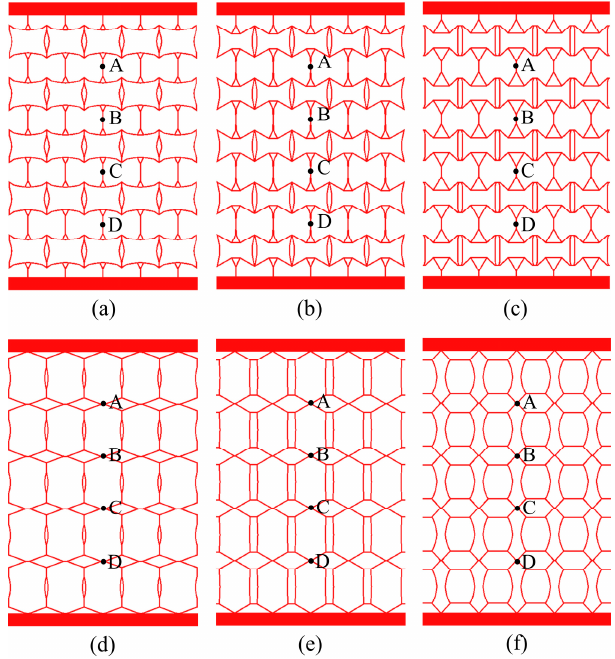
Figure 7. Metamaterials of various PR values: ( a ) 𝜈 = −0.3 ; ( b ) 𝜈 = −0.6 ; ( c ) 𝜈 = −1.0 ; ( d ) 𝜈 = +0.3 ; ( e ) 𝜈 = +0.6 ; ( f ) 𝜈 = +1.0 .